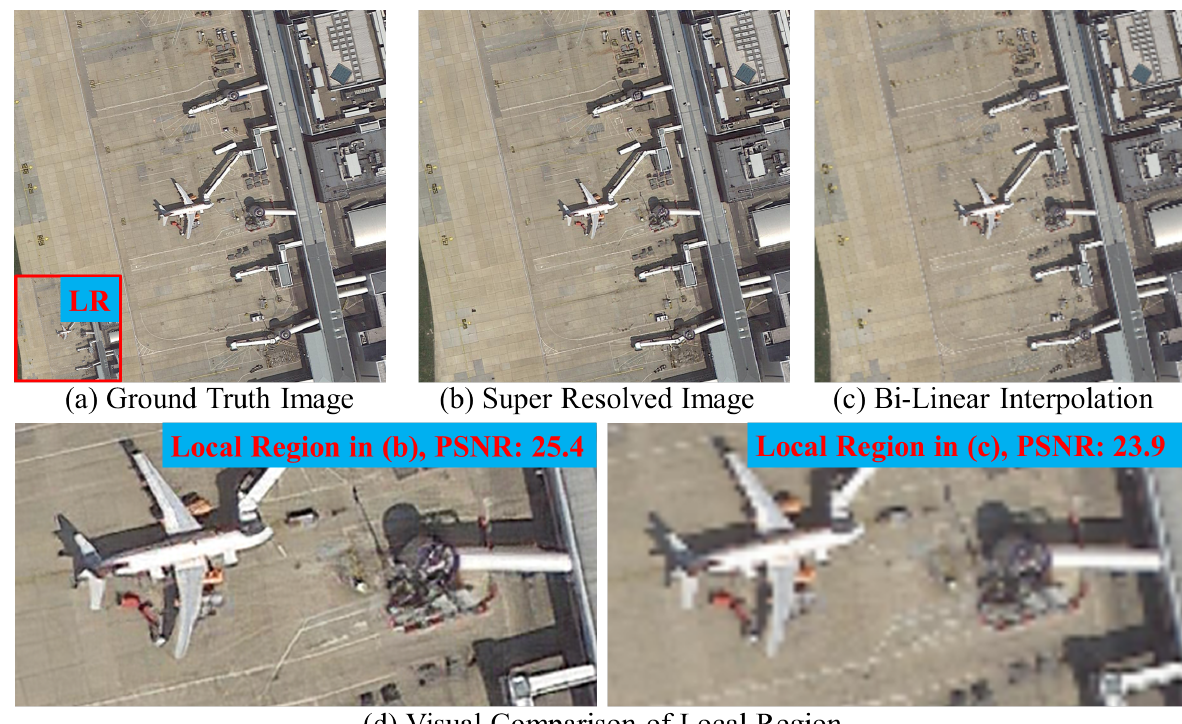
Figure 6. Visual comparison of two up-sampling methods (our HSOD-Net and bi-linear interpolation) for two random images in DOTA validation